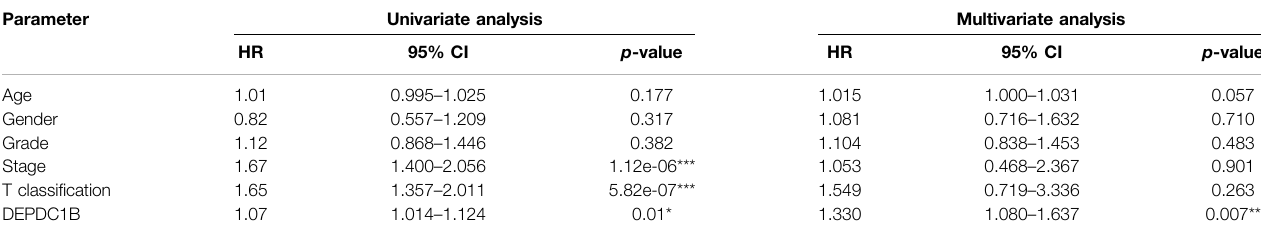
TABLE 3 | Univariate and multivariate analysis of the correlation of DEPDC1B expression with OS among LIHC patients. Parameter